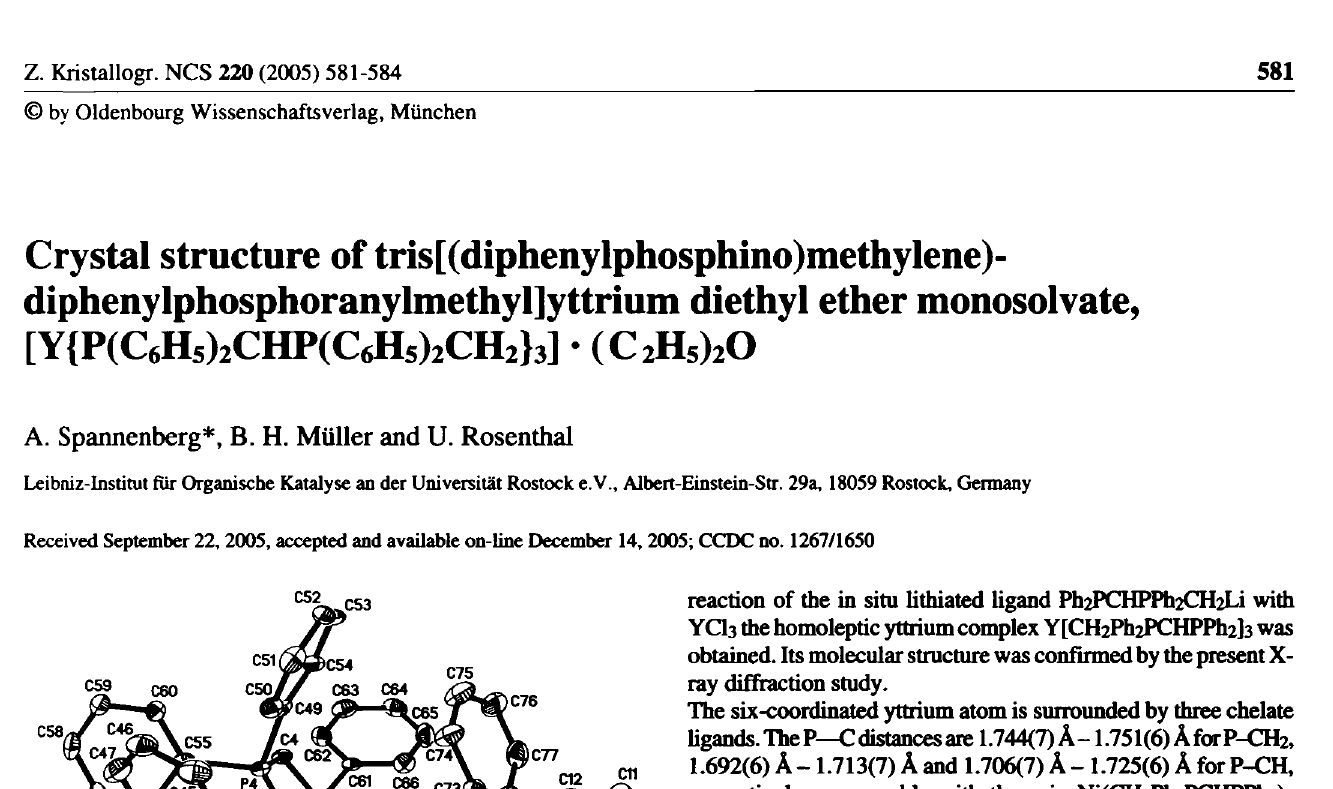
Table 1. Data collection and handling.